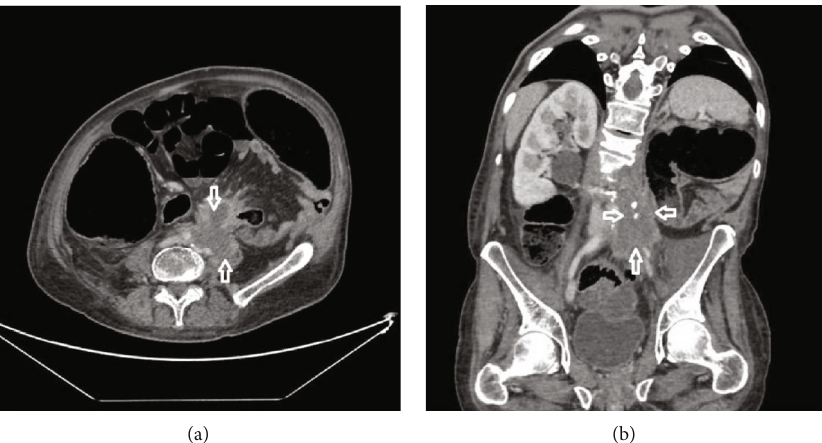
Figure 3: Abdominal CT scan showing a left lateroaortic mass (a) spanning over 12cm and in fi ltrating the left psoas and iliac muscles, as well as the left iliac vessels (b).